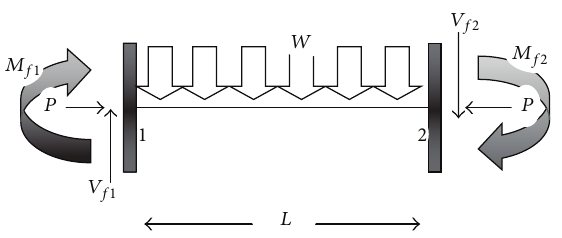
Figure 13: Beam column due to axial load